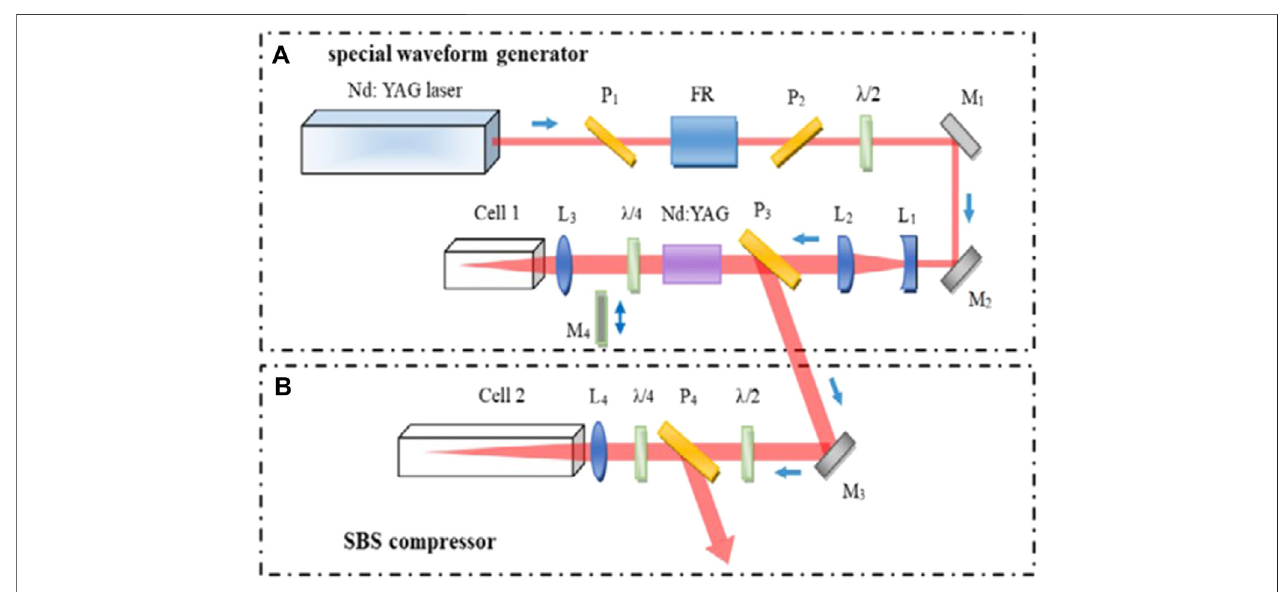
FIGURE 4 | Schematic diagram of experimental setup: (A) special waveform generator, (B) single-pass SBS compressor [74].